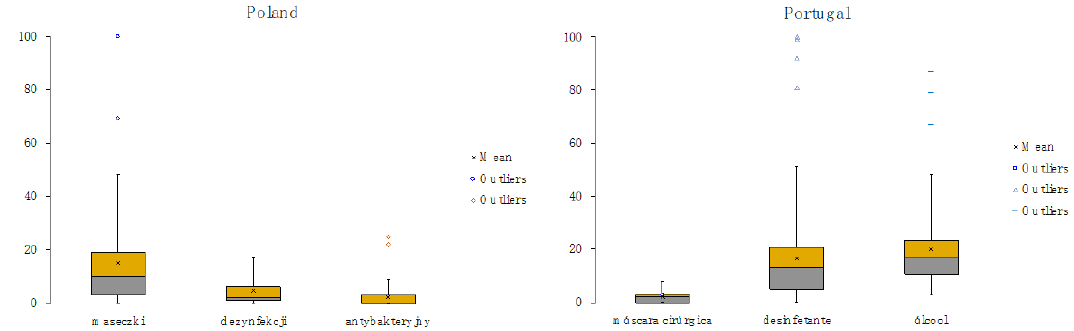
Figure 2. BoxPlot graphs of the keywords in GT in Poland and Portugal from January 20 to June 15.